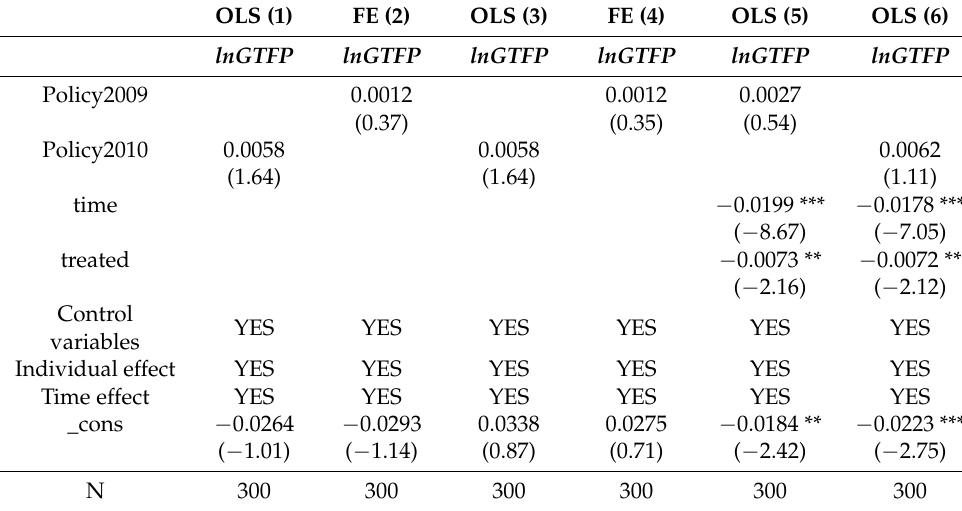
Table 5. Benchmark model parameter estimates of the counterfactual test.